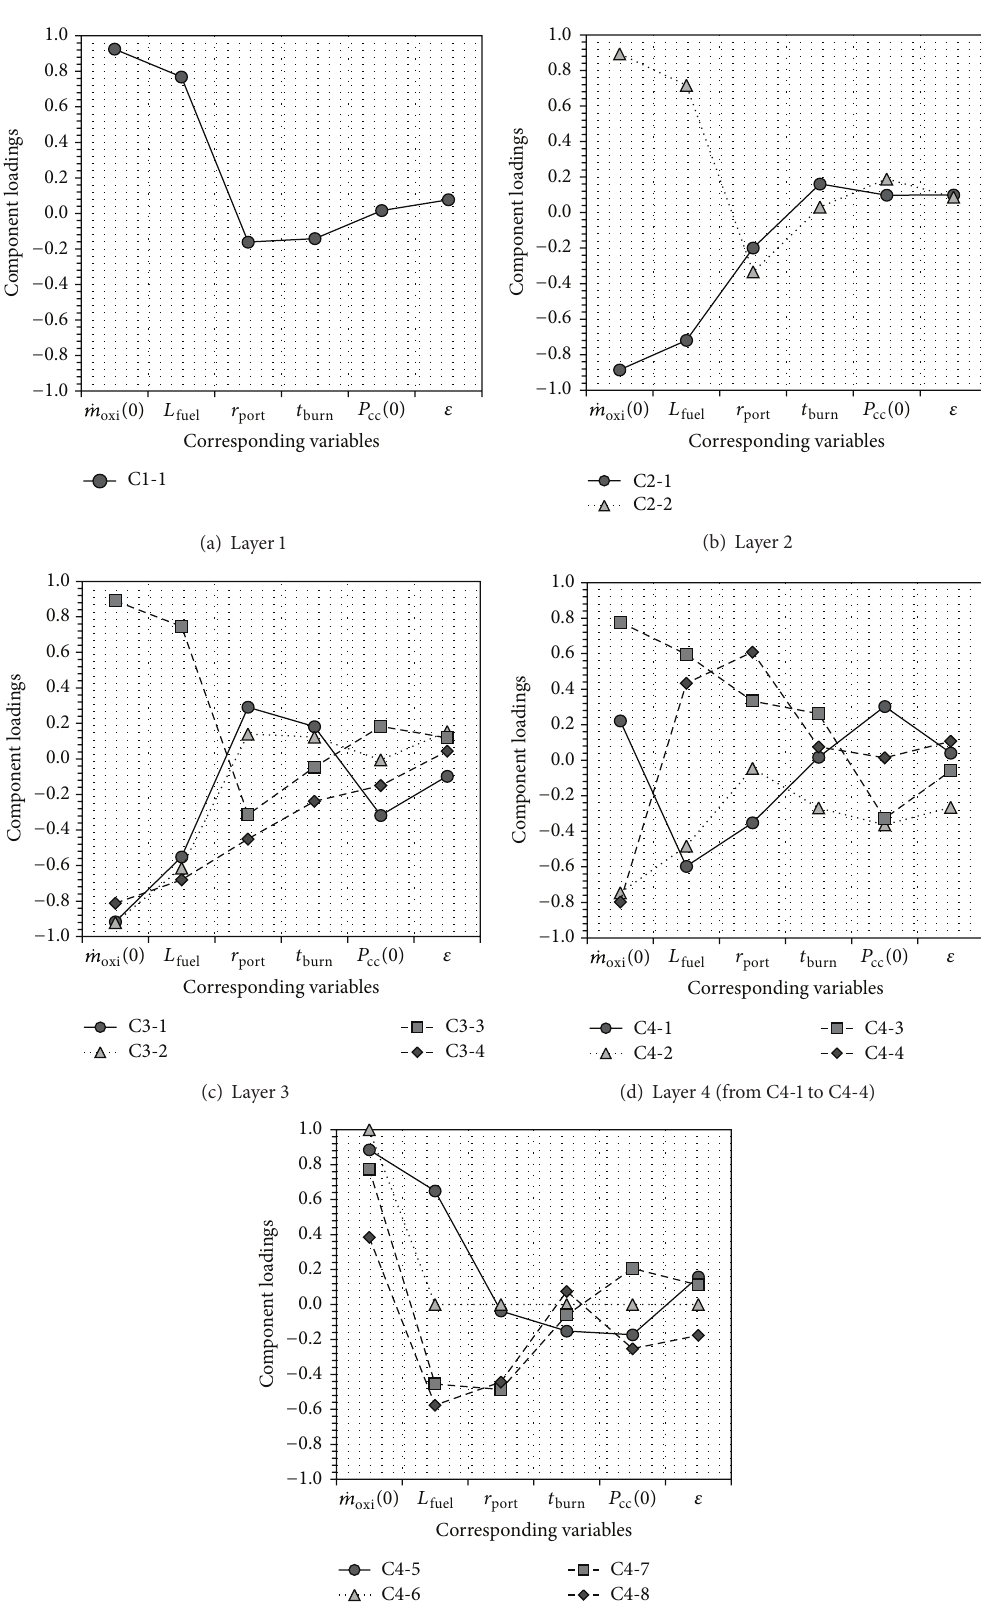
Figure 17: Mode 1 component loadings of each cluster at each